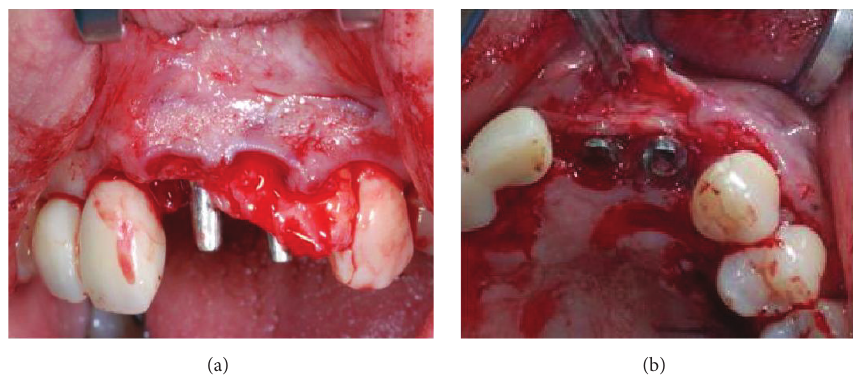
Figure 15: Tissue graft being positioned at implant site #8.